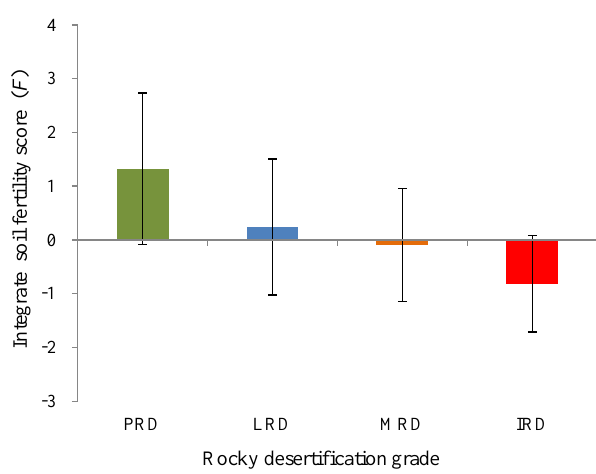
Figure 2. Average scores of integrate soil fertility of 20 studied plots. PRD, LRD, MRD, and IRD refer to potential, light, mod- erate, and intensive rocky desertification, respectively. Paired dif- ference were analyzed as p (LRD) = 0.111, p (MRD) = 0.254, and p (IRD) = 0.097 compared to PRD. The hanging bars refer to the standard deviation of the